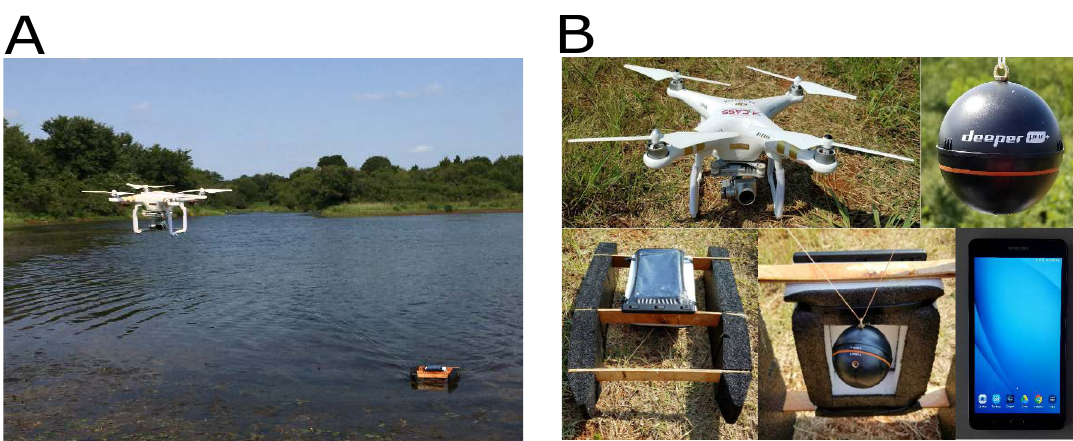
Figure 2. small UAS-echosounder system. ( A ) DJI Phanton 3 Pro quadcopter propelling a mini-boat carrying the single-beam echosounder across the Finn Creek Site 21 Reservoir; ( B ) DJI Phantom 3 Professional unmanned aerial system, Deeper Smart Sonar Pro+ wireless sonar, boat (top showing tablet attached in waterproof case and bottom showing attachment of sonar), and Samsung Android